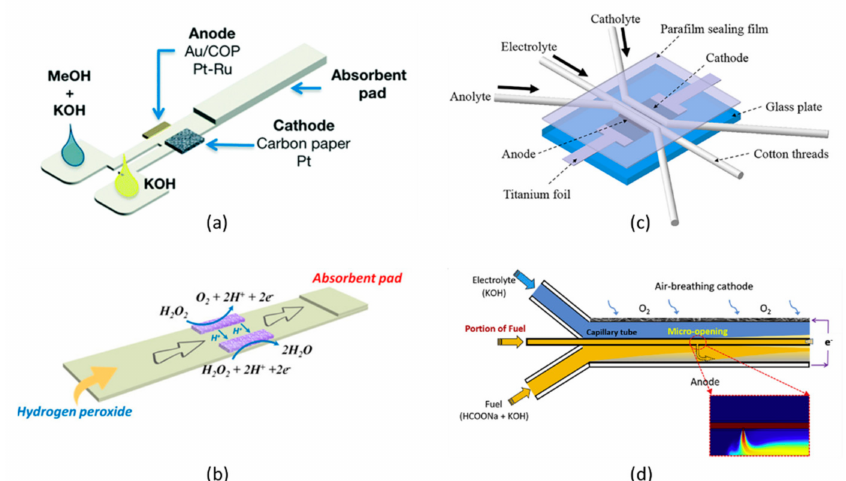
Figure 10. Multiple flow configurations adopted in LFMMFCs: ( a ) lateral co-flow MMFC on paper (reprinted from ref. [87]), ( b ) single-stream LFMMFC with hydrogen peroxide as fuel and oxidant (reprinted from ref. [148]. Copyright 2018 Wiley Online Library), ( c ) multi-stream MMFC with flow-through cotton threads (reprinted from ref. [127]. Copyright 2019 Wiley Online Library), ( d ) multi-stream MMFC with lateral flow through capillary tube to create micro-jet (reprinted from